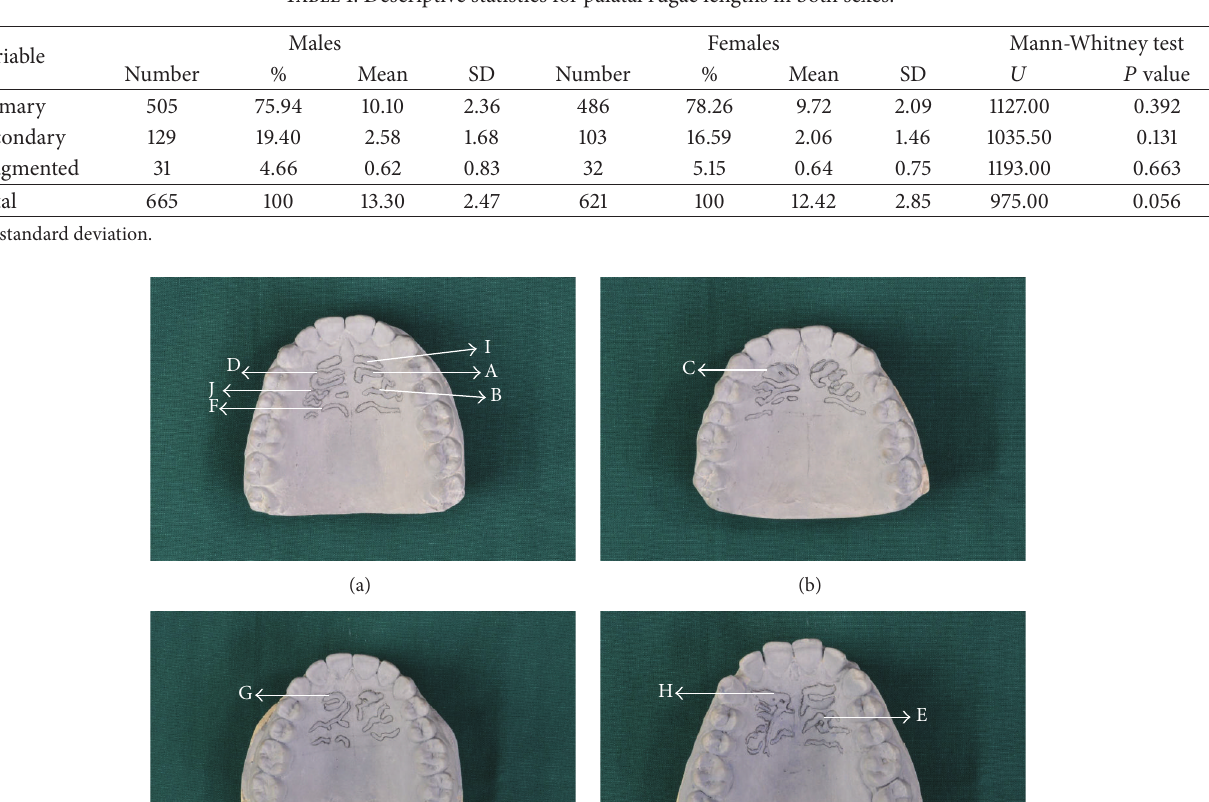
The least common form in both sexes was the